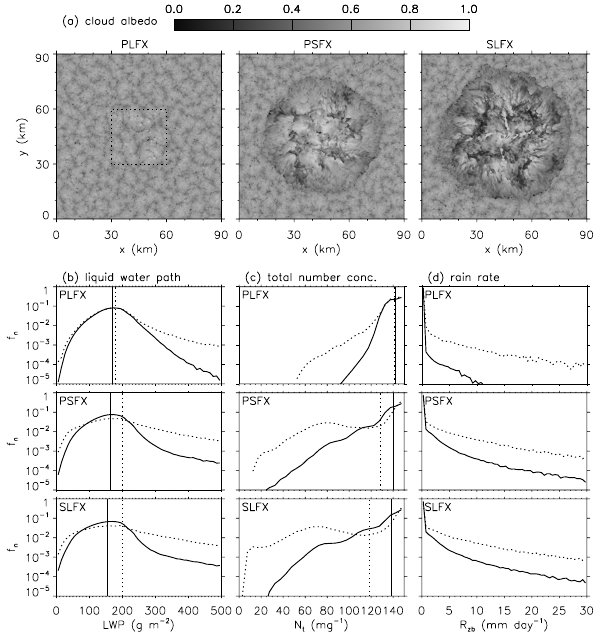
Fig. 8. Same as Fig. 5 but for experiments PLFX, PSFX and SLFX.